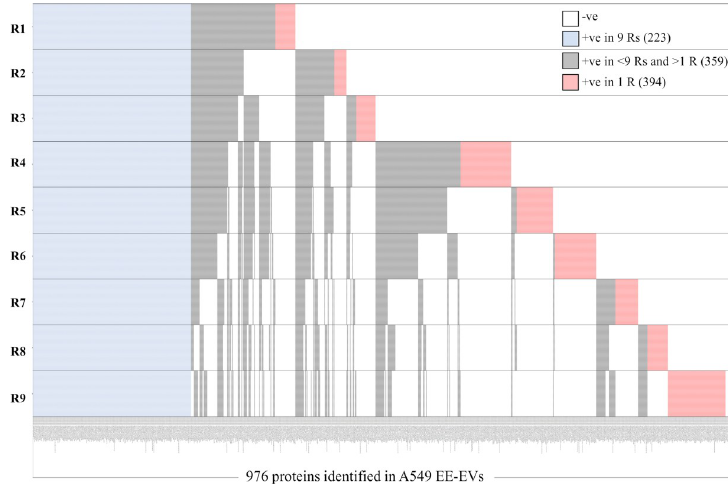
Fig 5. Heatmap showing number of samples in which each of the total 976 proteins was identified in A549 exosomes. Proteins common to all nine replicates are shown in blue (223). Proteins present in > 1 replicate and < 9 replicates are shown in grey (359) and proteins present only in 1 replicate are shown in red